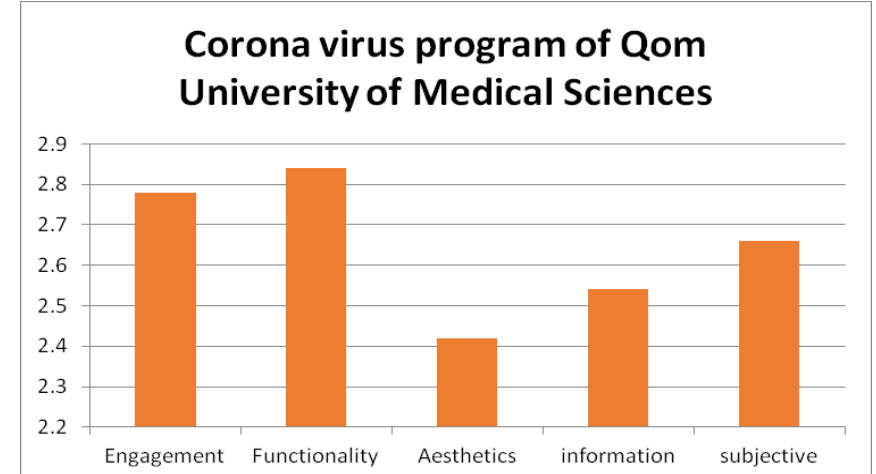
Fig 4. The evaluation of indicators in Coronavirus Program of